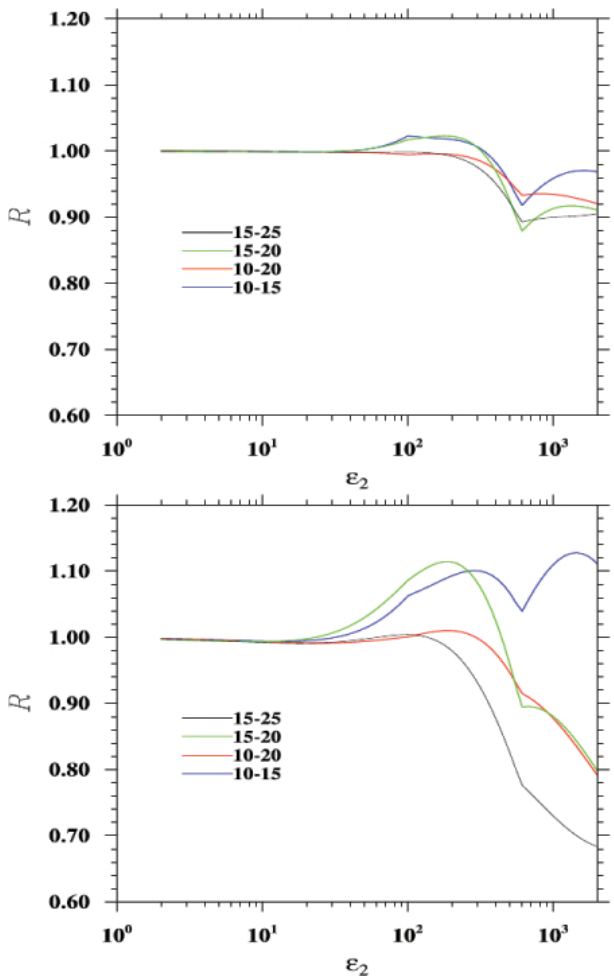
Fig. 2. The ratio R as a function of the dissipation rate (cid:15) 2 (in cm 2 s − 3 ) for selected pairs of droplet radii (in µm) and for l 2 /l 1 = 10 (upper panel) and l 2 /l 1 = 1000 (lower